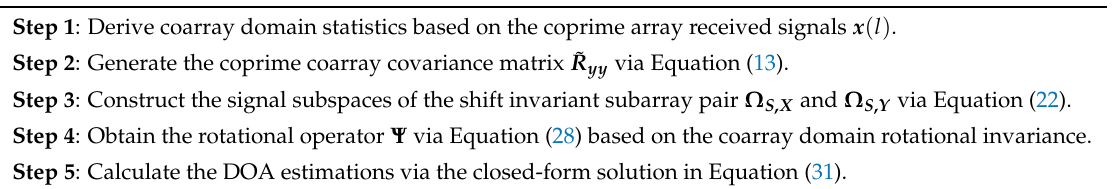
Table 1. Steps for the proposed coprime array direction-of-arrival estimation